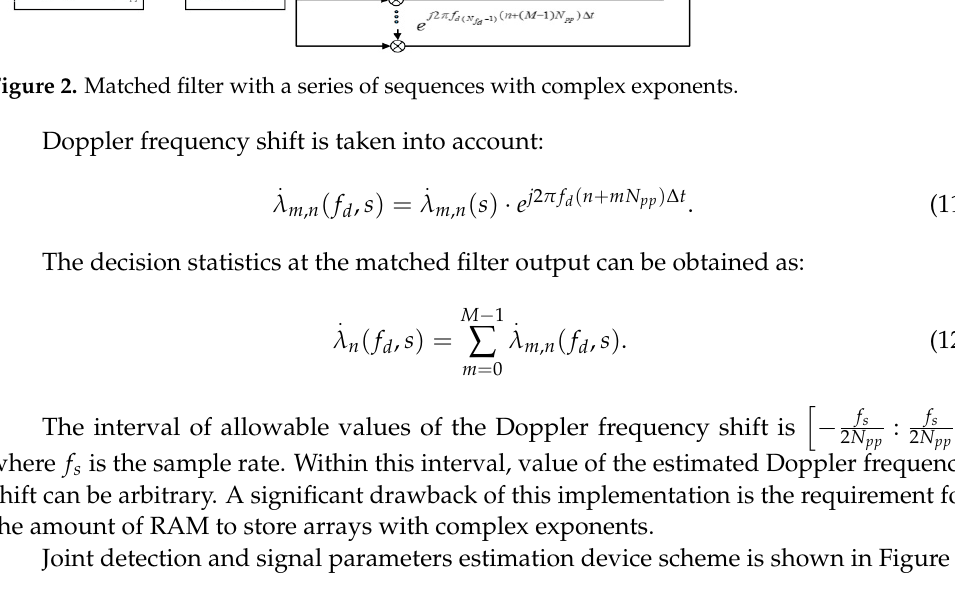
Figure 3. Scheme of the device for joint detection and signal parameter estimation.